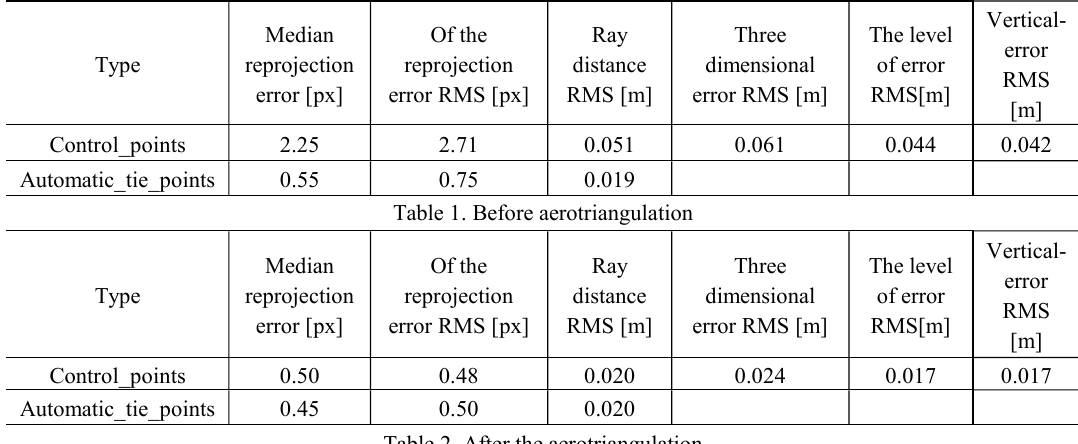
Table 2. After the